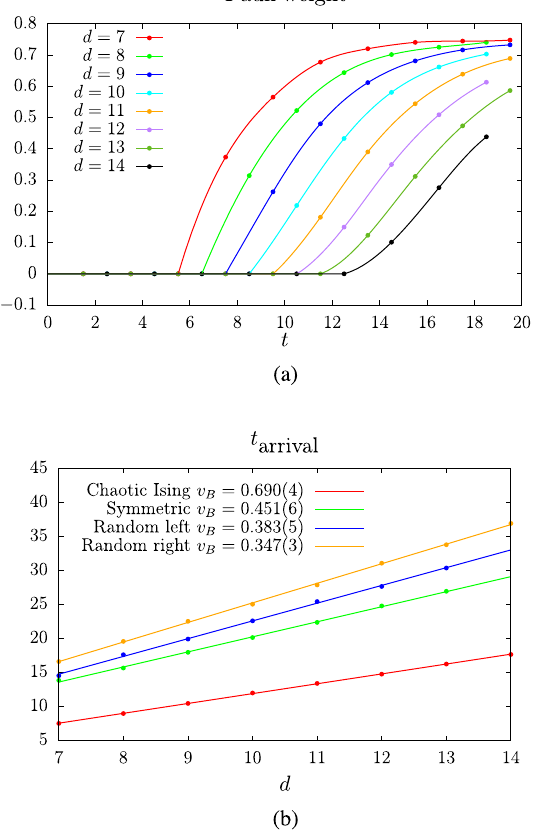
FIG. 18. (a) Pauli weight for the kicked-Ising model with parameters in Eq. (80). (b) Estimation of v by fitting t B arrival versus d . “ Chaotic Ising ” is the kicked-Ising model with the parameters in Eq. (80), while “ Symmetric ” and “ Random ” refer to the generic parity-symmetric gate with x ¼ 0 . 8 [Eq. (72)] and the fixed random parity-asymmetric gate (see Sec. VA and Appendix B 2). For the asymmetric gate, we fit separately for the left and right butterfly velocities. For the dual-unitary model 1 exactly. (not shown), v B ¼